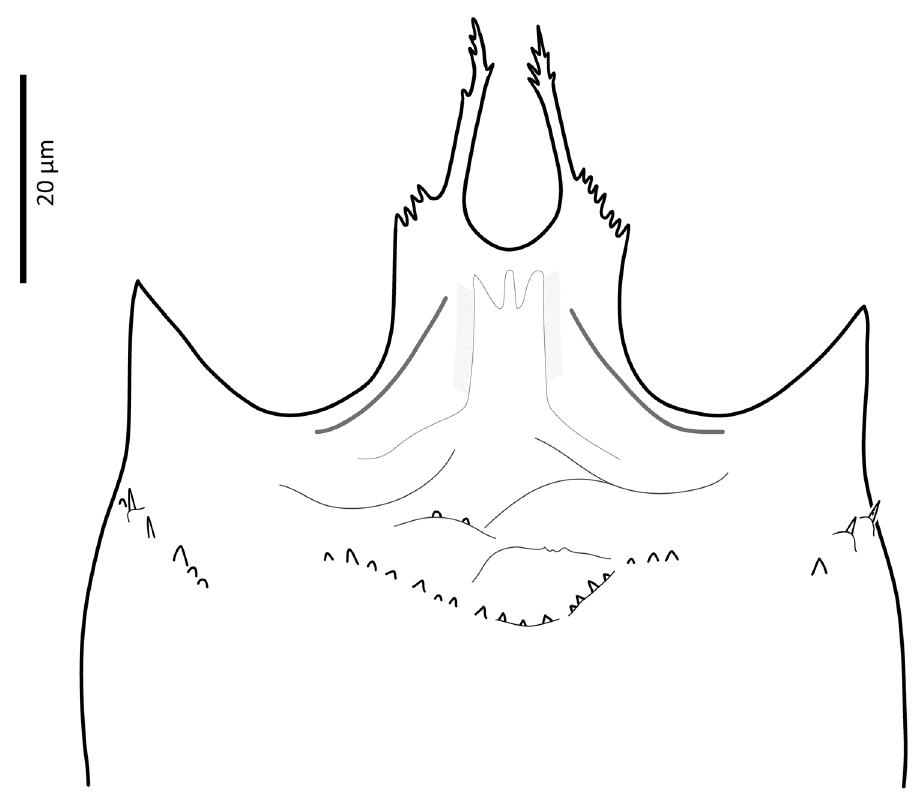
Figure 20. Zygoseius lindquisti sp. n., female,